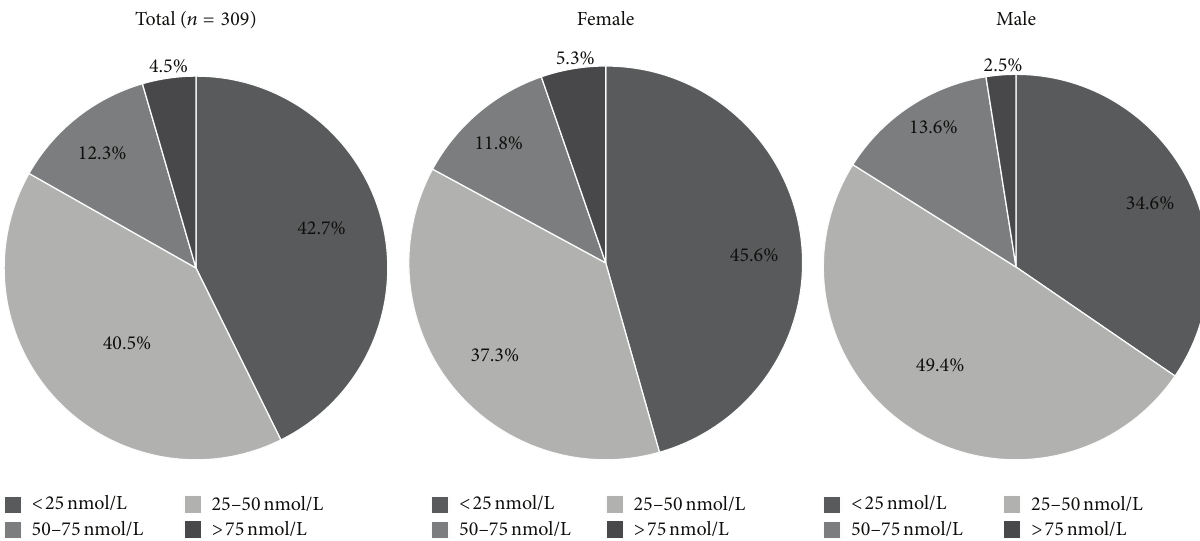
Figure 1: Serum 25(OH) vitamin D status in males and females according to cut-off values. Note: vitamin D deficiency was defined as s- 25(OH)D < 50 nmol/L.